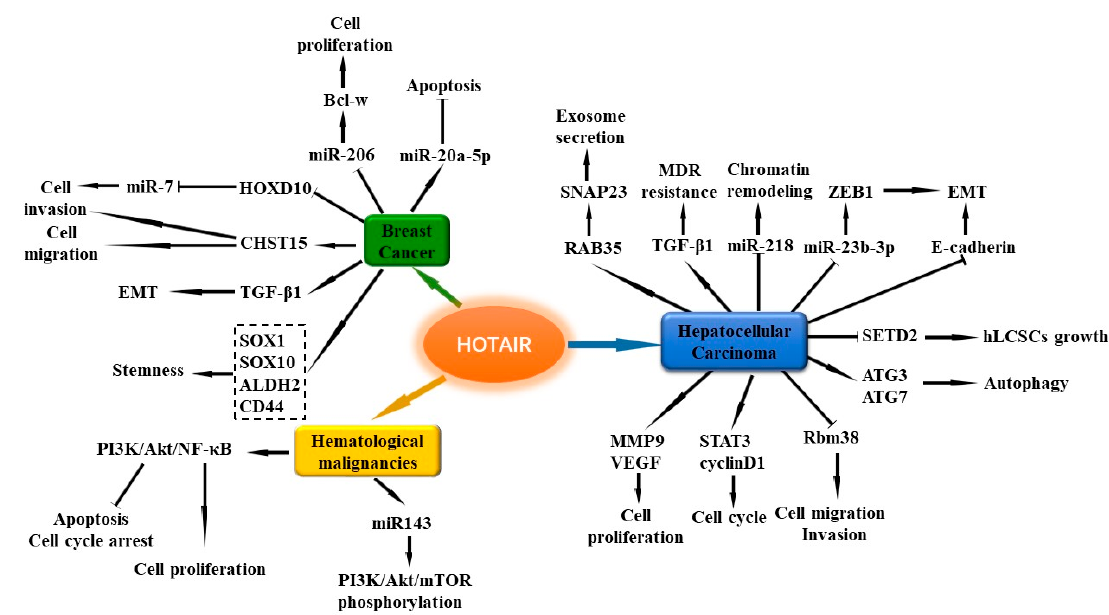
Figure 1. Proposed mechanisms of MALAT1 in various cancers.